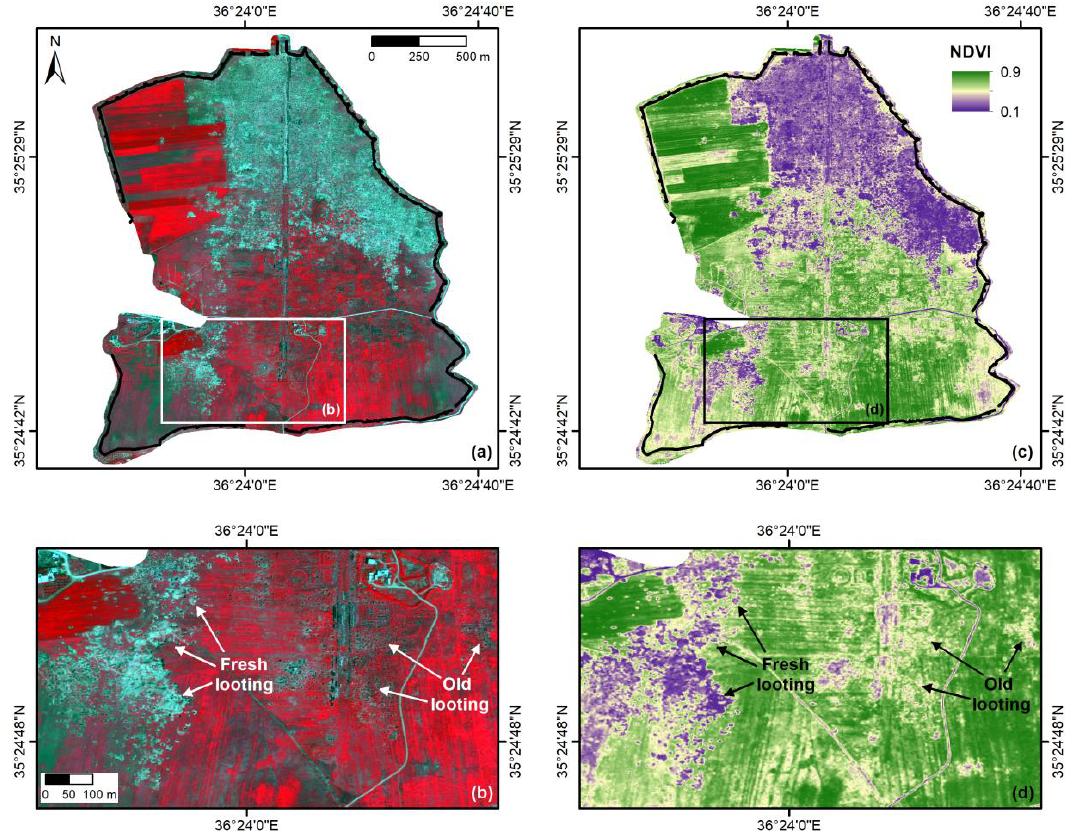
Figure 10. Archaeological looting at Apamea (Syria) captured with pansharpened 30-cm WorldView-2 image (03 / 04 / 2017) displayed as: ( a , b ) false-colored infrared (R: Band 4—NIR1; G: Band 3—red; B: Band 2—green) and ( c , d ) Normalized Di ff erence Vegetation Index (NDVI). Zoomed views ( b , d ) highlight the marked di ff erence in spectral signature of fresh vs. old looting features. WorldView-2 product © 2018 DigitalGlobe, Inc. Distributed by e-GEOS